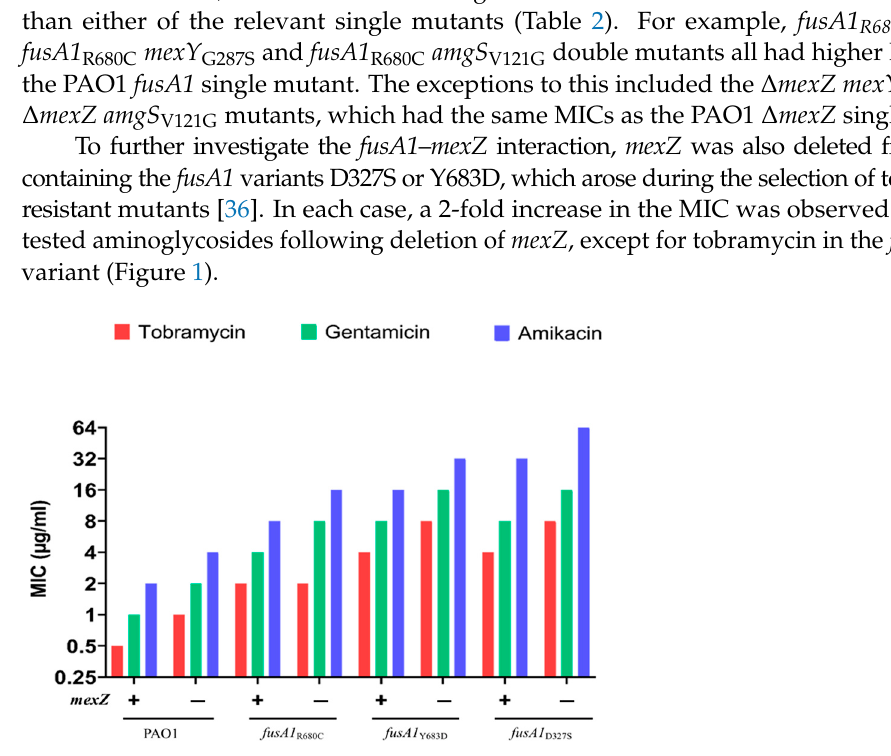
Figure 1. Additive effects of fusA1 and mexZ mutations. The MICs of tobramycin, gentamicin and amikacin were measured for the PAO1 strain, genetically engineered f usA1 R680C , tobramycin-evolved spontaneous fusA1 variants (Y683D and D327S) and their mexZ isogenic mutants. The presence and absence of mexZ are represented as “+” and “ − ”, respectively .